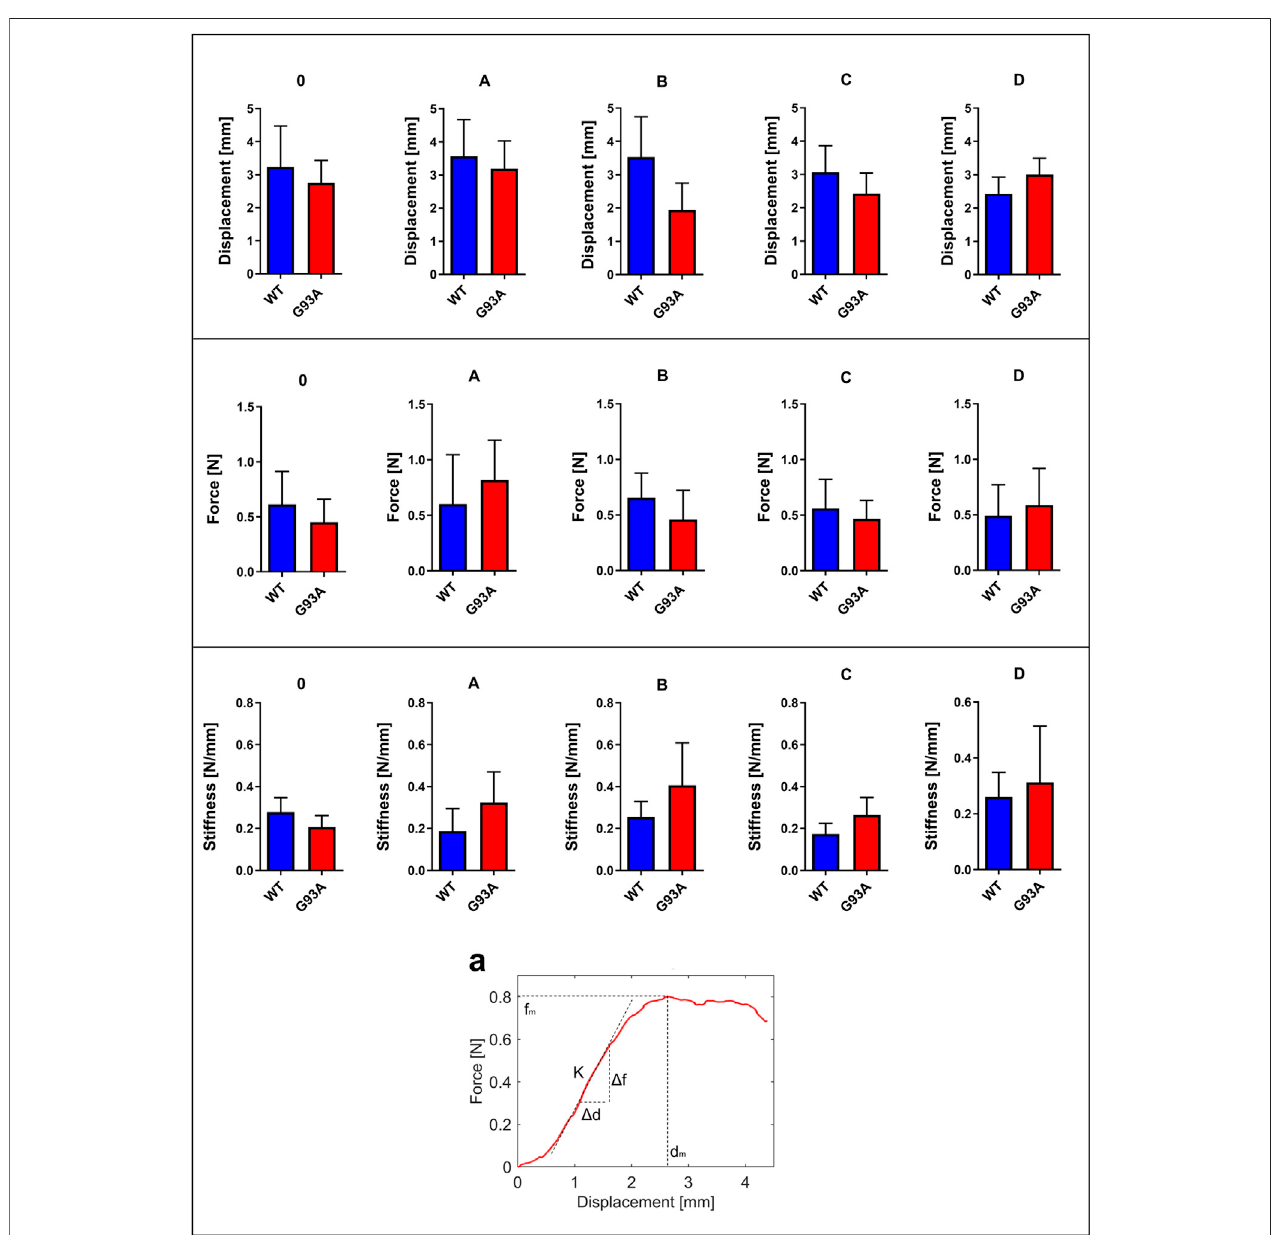
FIGURE2| Force,displacement,andstiffnessvaluesoflungtissuesbelongingtoSOD1 G93A andSOD1 WT rats.(a)Thestiffnessvalueoflungtissueiscalculatedas represented by the fi gure via using displacement and force values. * p ≤ 0.05, ** p ≤ 0.001 and *** p ≤ 0.000.